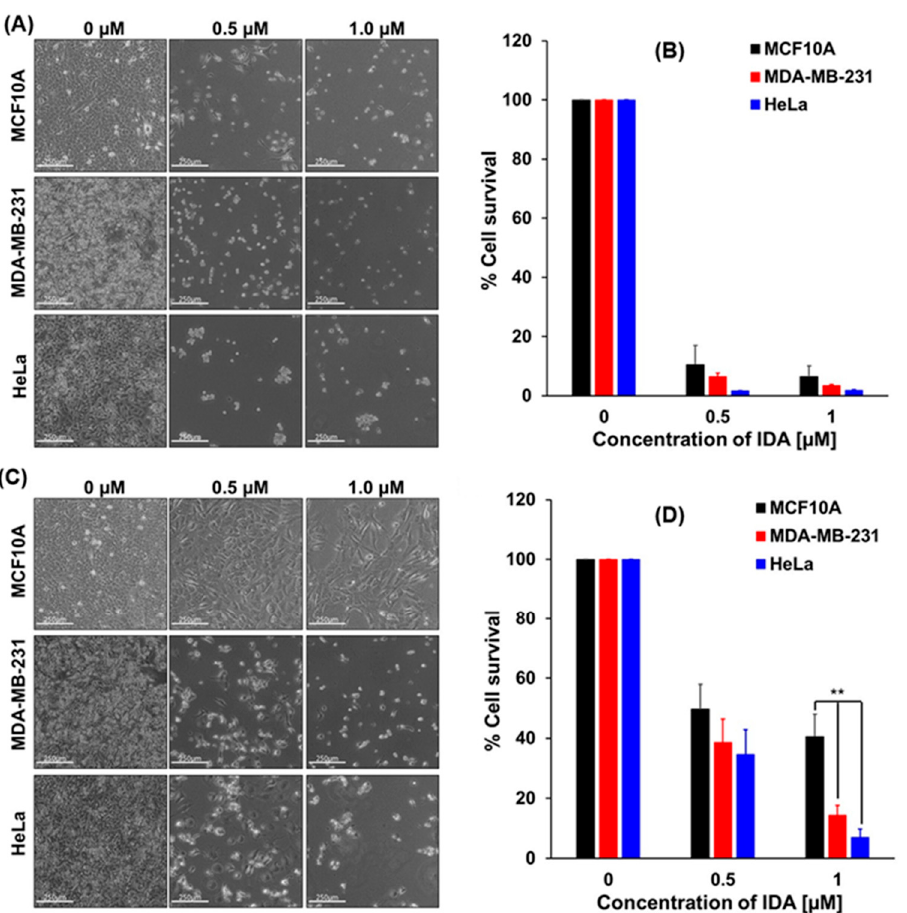
Figure 6. The effects of concentration of free IDA ( A , B ) and APO(IDA) ( C , D ) on cell growth of MCF10A, MDA-MB-231, and HeLa cells studied by the cytotoxicity/growth inhibition assay with crystal violet staining. ( A ) Representative brightfield images of cells cultured in the presence of free IDA, with IDA concentration, C IDA [ µ M]: 0.0, 0.5 and 1.0. ( B ) Normalized crystal violet signal representing cell survival for experiments in (A). ( C ) Representative brightfield images of cells cultured in the presence of APO(IDA), with equivalent concentration of C IDA [ µ M]: 0.0, 0.5 and 1.0. ( D ) Normalized crystal violet signal representing cell survival for experiments in ( C ). All data are expressed as mean ± SD ( n = 3); statistically significant differences in cell survival between MCF10A and MDA-MB-231 ( P = 0.0052) and between MCF10A and HeLa ( P = 0.0019) is shown as “**”. Scale bars in all images (A,C) are 250 µ m. Table 2. Half-maximal effective concentrations EC 5 = for free ANTR drugs and